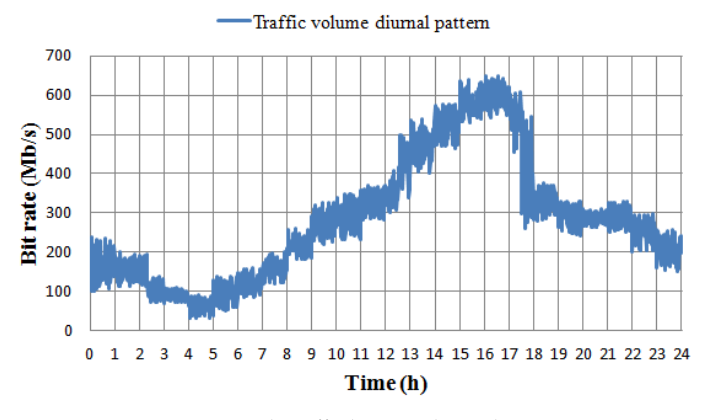
Figure 14. Link traffic bit rate diurnal pattern.